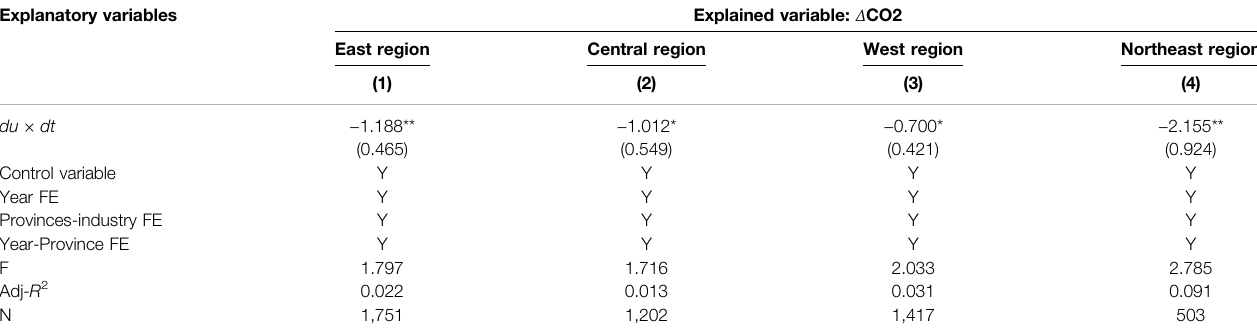
TABLE 8 | Regional heterogeneity